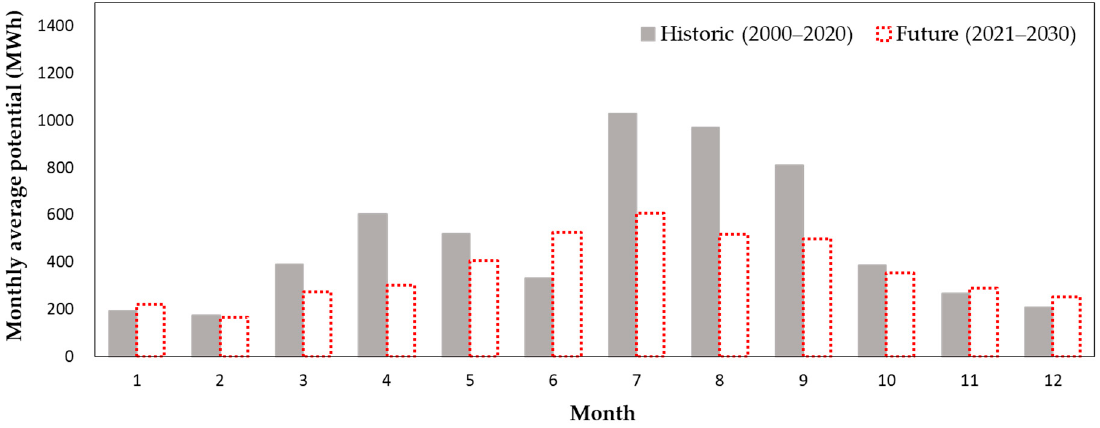
Figure 5. Monthly average potentials of the historic and future periods.